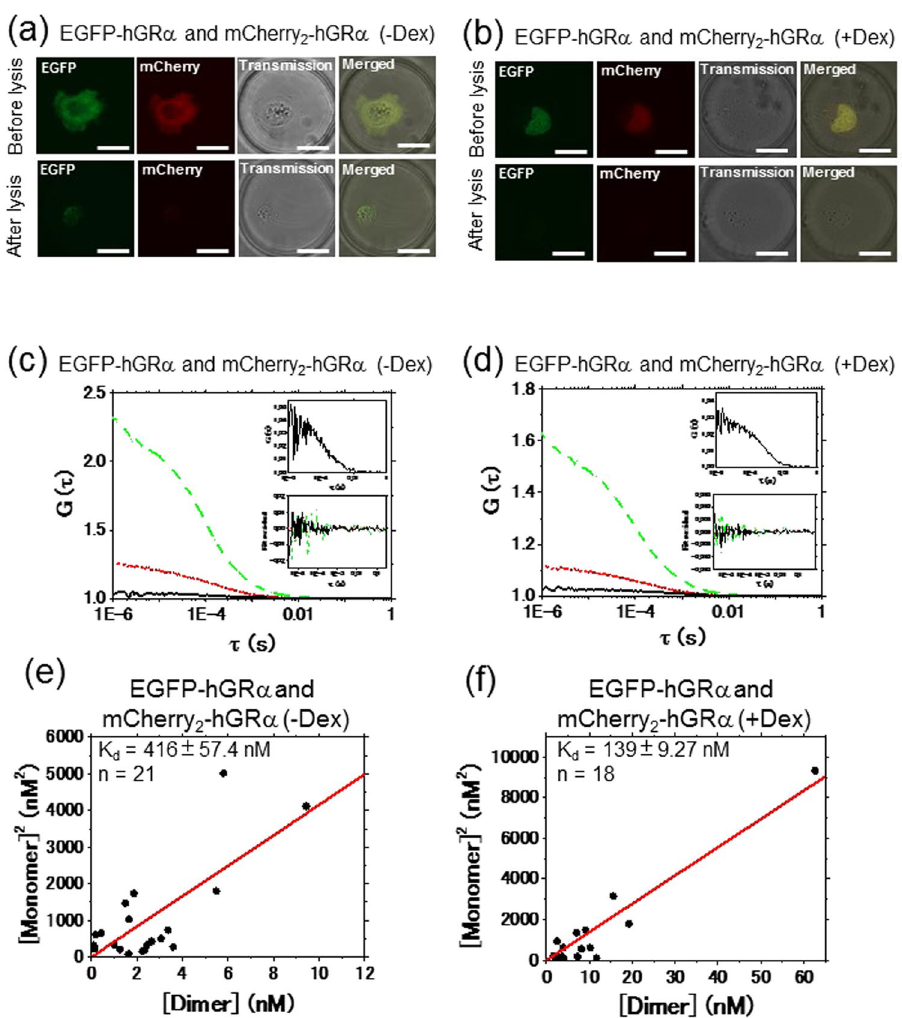
Figure 1. In vitro K d analysis of EGFP-GR α and mCherry 2 -GR α using the FCCS-microwell system. Typical auto- and cross-correlation curves constructed by measurements in microwells after lysis of U2OS cells coexpressing EGFP-hGR α and mCherry 2 -hGR α in the absence or presence of Dex. The green dashed line, red dotted line, and black solid line denote the autocorrelation of the green channel [ G G ( τ )], autocorrelation of the red channel [ G R ( τ )], and cross-correlation [ G C ( τ )], respectively. The insets show an enlarged graph of the cross-correlation curve and fitting residuals of autocorrelation and cross-correlation curves. LSM images of U2OS cells coexpressing EGFP-hGR α and mCherry 2 -hGR α before and after cell lysis in the absence ( a ) and presence ( b ) of Dex. The scale bar is 20 μ m. FCCS was performed in a microwell after cell lysis in the absence ( c ) and presence ( d ) of Dex. ( e, f ) Results of K d determination using a scatter plot and linear regression. The plots represent the square of the concentration of the monomeric hGR α versus the concentration of the dimer of hGR α . The solid red line shows the linear fit. The slope indicates K d . ( e ) mCherry 2 -hGR α and EGFP-hGR α in the absence of Dex. ( f ) mCherry 2 -hGR α and EGFP-hGR α in the presence of